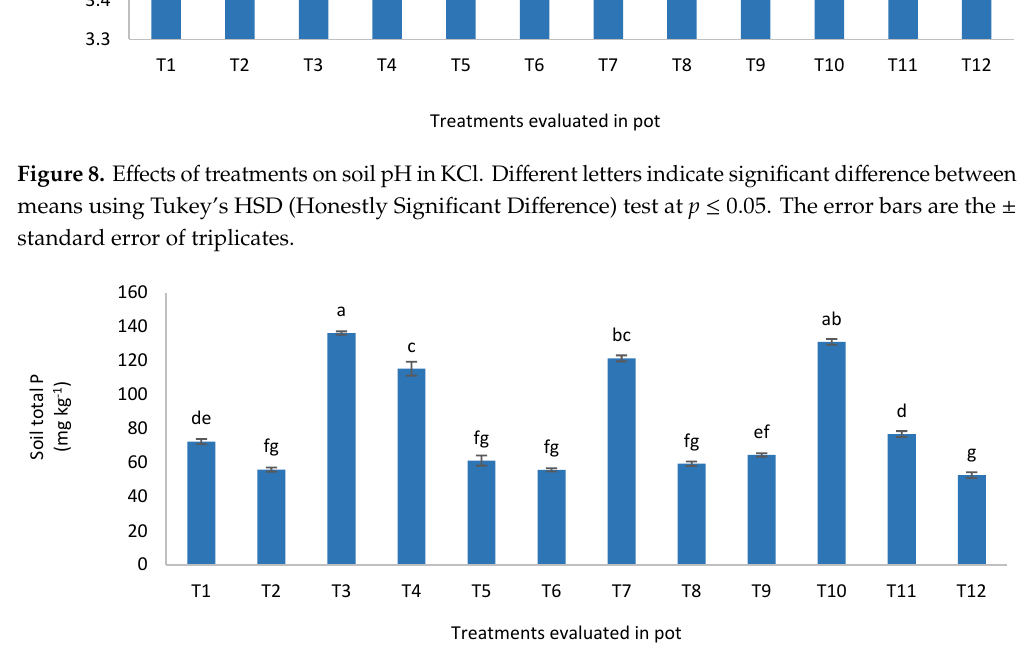
Figure 9. E ff ects of treatments on soil total phosphorus. Di ff erent letters indicate significant di ff erence Figure 9. Effects of treatments on soil total phosphorus. Different letters indicate significant difference between means using Tukey’s HSD (Honestly Significant Di ff erence) test at p ≤ 0.05. The error bars are of CLB. between means using Tukey’s HSD (Honestly Significant Difference) test at p ≤ 0.05. The error bars the ± standard error of triplicates. are the ± standard error of triplicates.